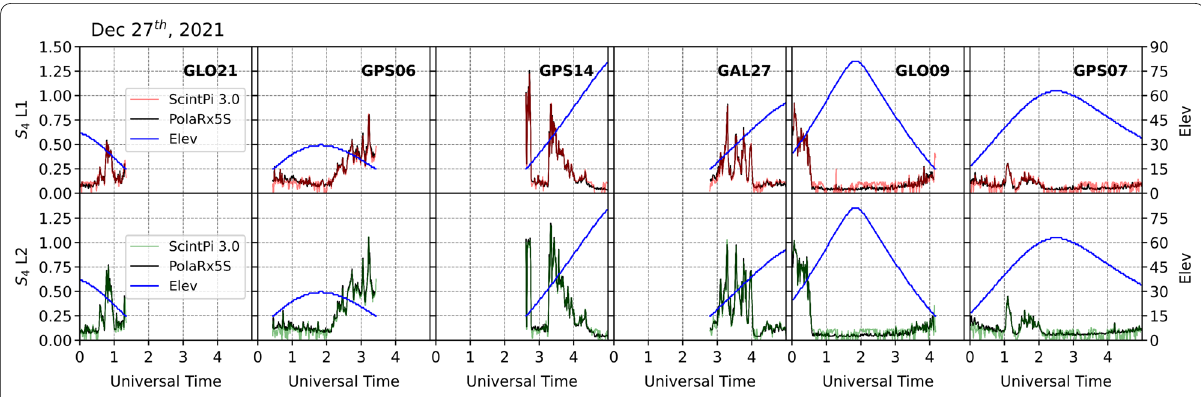
Fig. 5 Expanded views of a few L1 (top) and L2 (bottom) scintillation events measured at Presidente Prudente on December 27,